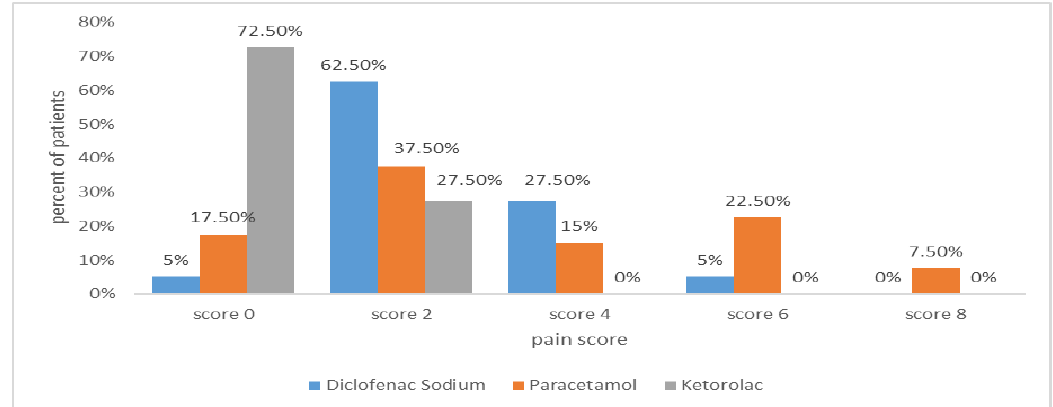
Figure 2.Percent of the frequency of pain score for the study groups after 60 minutes of surgery.